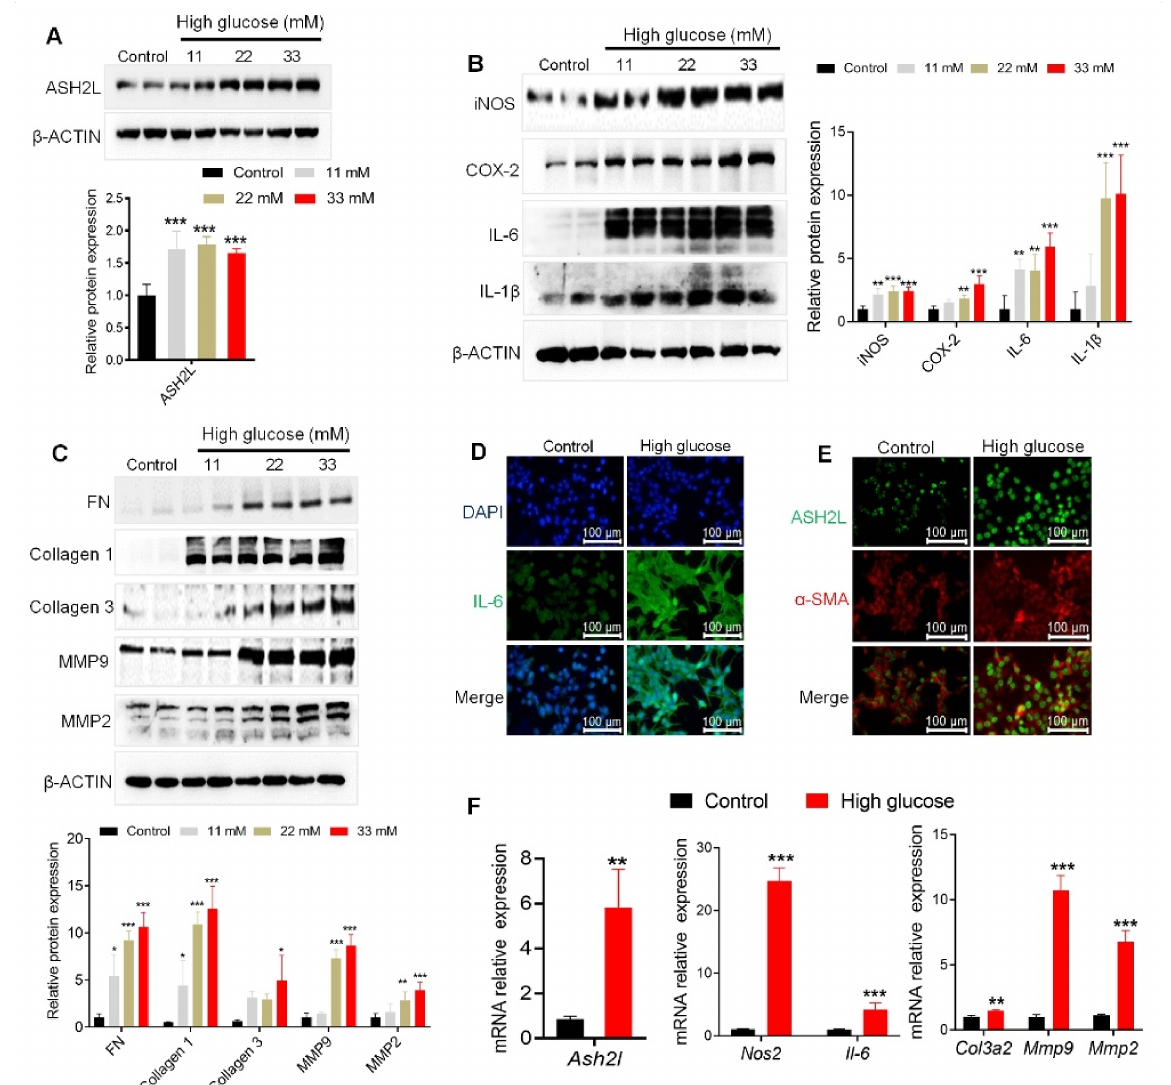
Figure 1. High glucose activates ASH2L aligned with fibrosis and inflammation in mesangial cells. ( A – C ) Western blot analysis of ASH2L, fibrosis markers (FN, Collagen 1, Collagen 3, MMP9, and MMP2), and inflammatory mediators (iNOS, COX-2, IL-6, and IL-1 β ) expression in SV40-MES-13 cells treated with 11 mM, 22 mM, and 33 mM D-glucose for 24 h. Data from at least three independent experiments are shown as mean ± S.D, * p < 0.05, ** p < 0.01, and *** p < 0.001 compared with the control group. ( D , E ) Immunofluorescence staining of IL-6, ASH2L, and α -SMA in SV40-MES-13 cells treated with or without 33 mM D-glucose (high glucose) for 24 h. ( F ) Quantitative RT-PCR analyses of the relative mRNA levels of Ash2l , fibrosis-associated markers ( Col3a2 , Mmp9 , and Mmp2 ), and inflammatory mediators ( Nos2 and Il-6 ) in SV40-MES-13 cells treated with or without 33 mM D-glucose. Data from at least three independent experiments are shown as mean ± S.D, ** p < 0.01, and *** p < 0.001 compared with the control